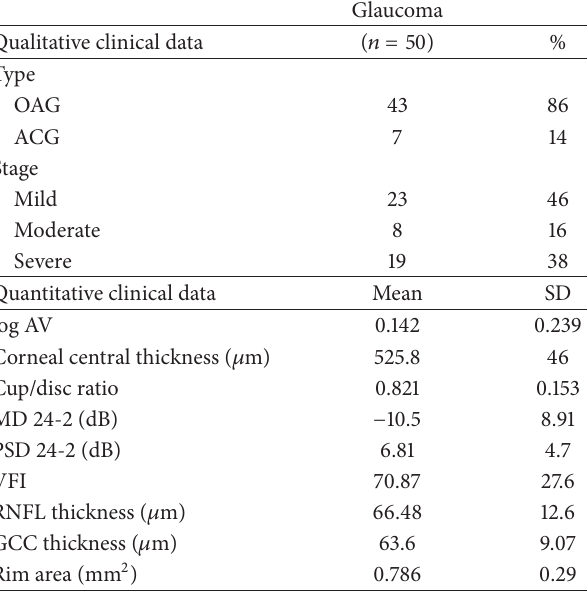
Table 2: Quantitative and qualitative clinical data. OAG: open- angle glaucoma; ACG: angle-closure glaucoma. Visual field and OCT spectral-domain testing. MD: mean deviation; PSD: pattern standard deviation; VFI: visual field index; RNFL: retinal nerve fiber layers; GCC: ganglion cell complex.